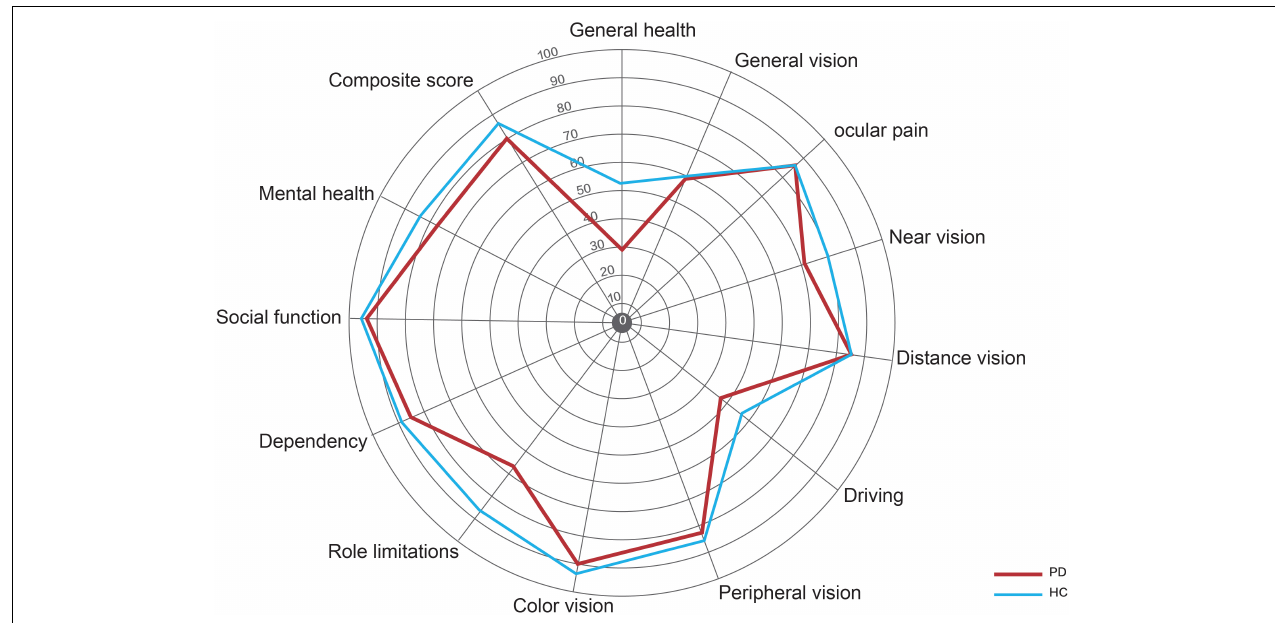
FIGURE 2 | Radar graph representing the mean scores for the various scales in the NEI VFQ-25. The red line represents the patients with PD, and the blue line represents the healthy controls.